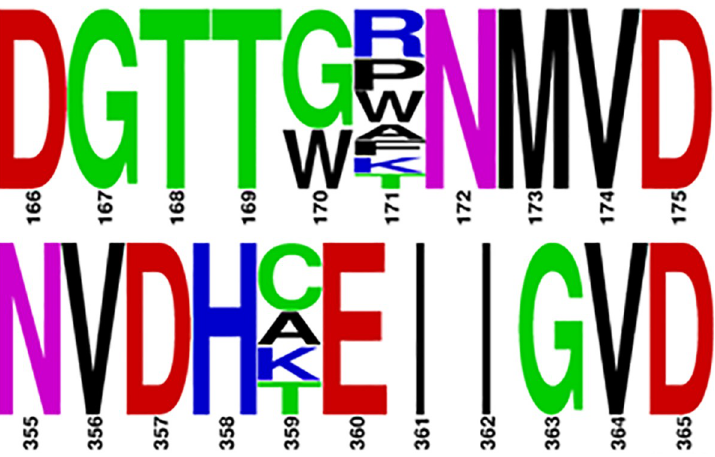
Fig 5. Mutations at different positions which showed improved differential activity during screening. Occurrences of GTL amino acids at the positions of mutation are ignored for better presentation. The figure and the colour code is generated by WebLogo [52].